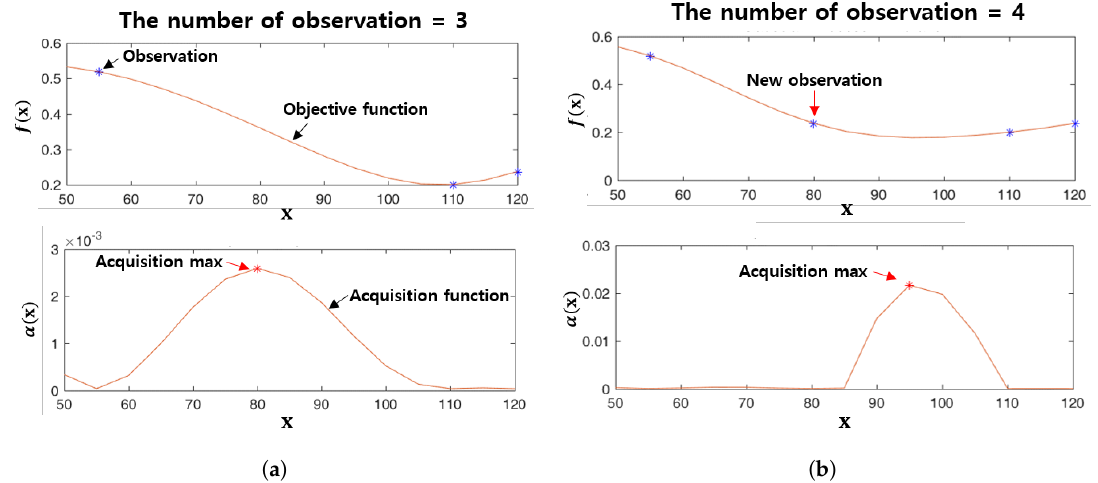
Figure 7. The Bayesian optimization procedure. ( a ) The number of observations is 3 ( b ) The number of observations is